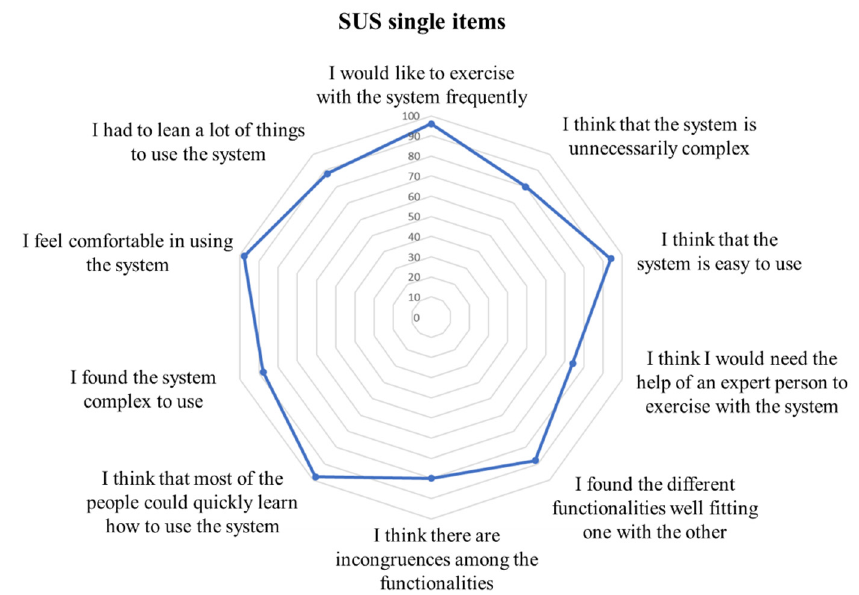
Figure 6. Mean values for each item of the System Usability Scale (SUS) scale in percentage. The highest the value, the more positive the result.